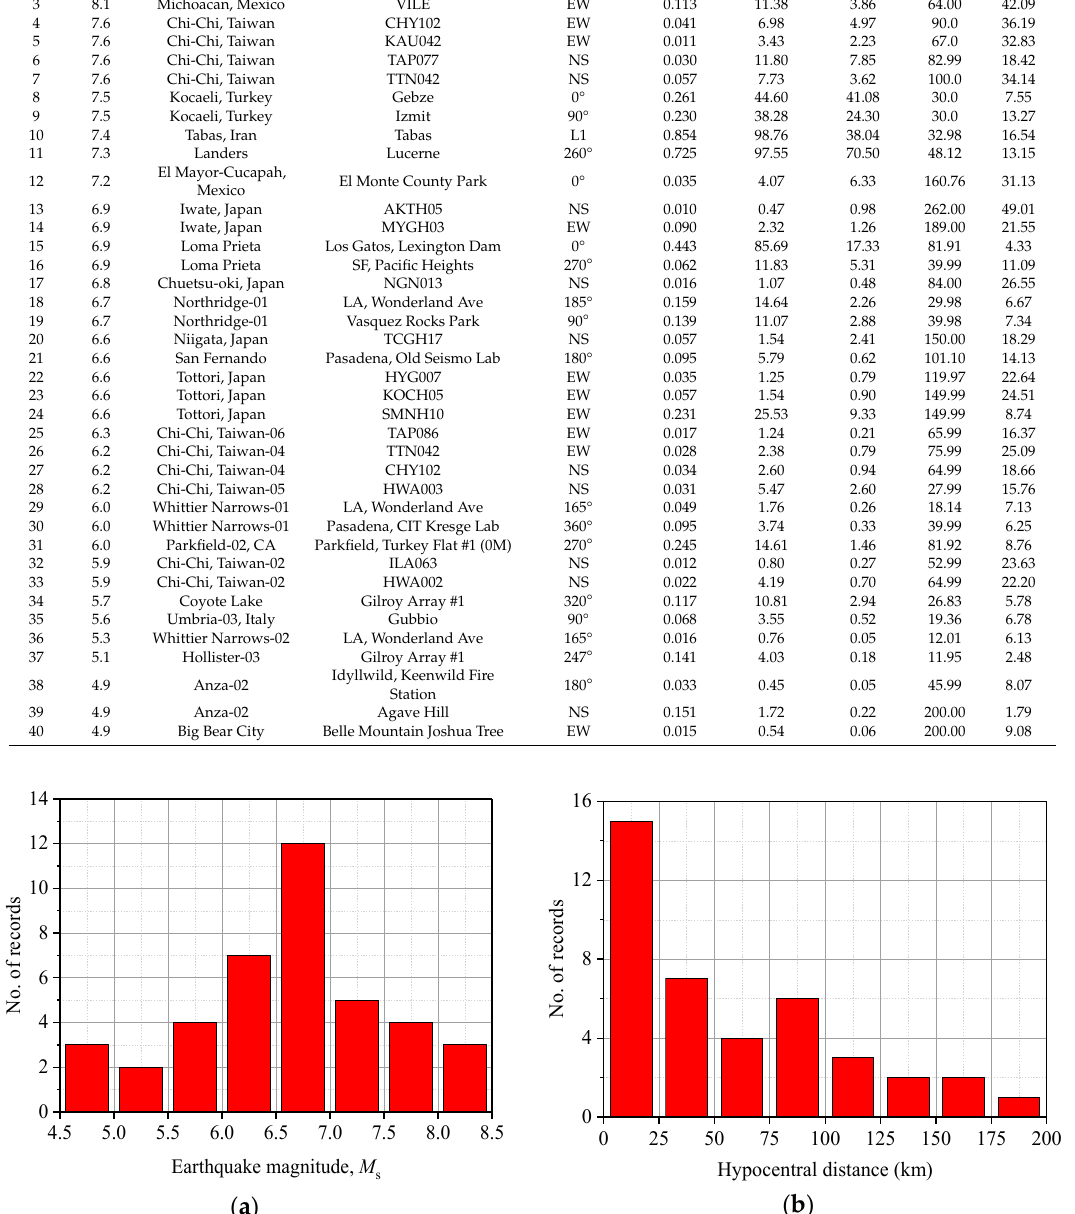
Figure 11. Distribution of selected ground motion records versus ( a ) earthquake magnitude and ( b ) hypocentral distance.